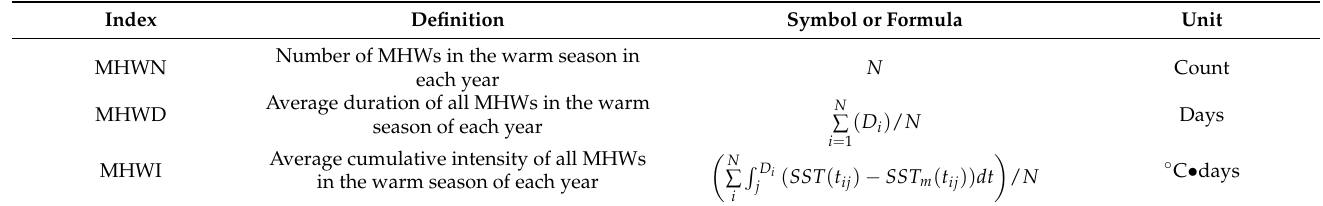
Table 1. Definitions of annual MHW indices. N is the number MHWs in the warm season of each year; D is the period between the start and end date of an MHW event; the cumulative intensity which is calculated as the sum of the difference between the daily SST for a certain day and the daily climatological mean ( SST m ) over the MHW duration ( D ). Notably, here the anomaly refers to a deviation of daily SST from the climatological mean which we used for the fixed-baseline period